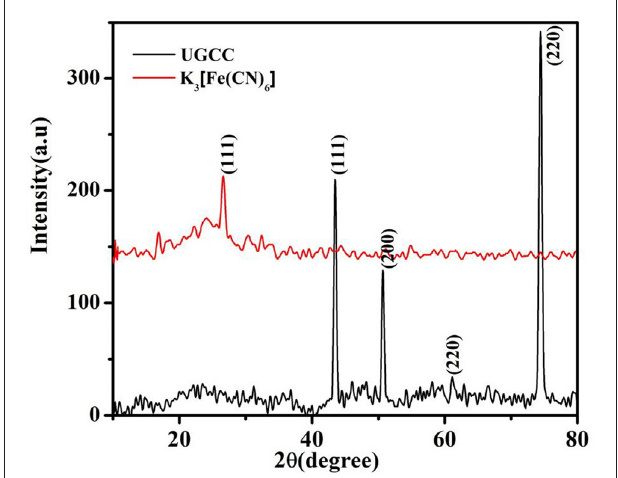
FIGURE 5 | XRD of UGCC electrode and